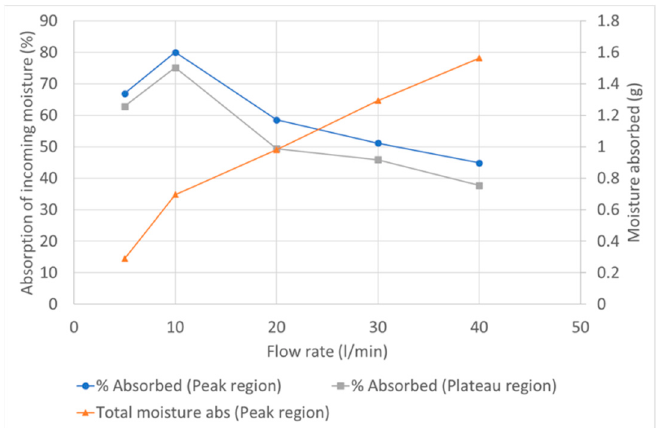
Figure 7. Proportion of moisture captured by the SIM during peak temperature and plateau regions and magnitude of moisture absorbed during the peak temperature region.